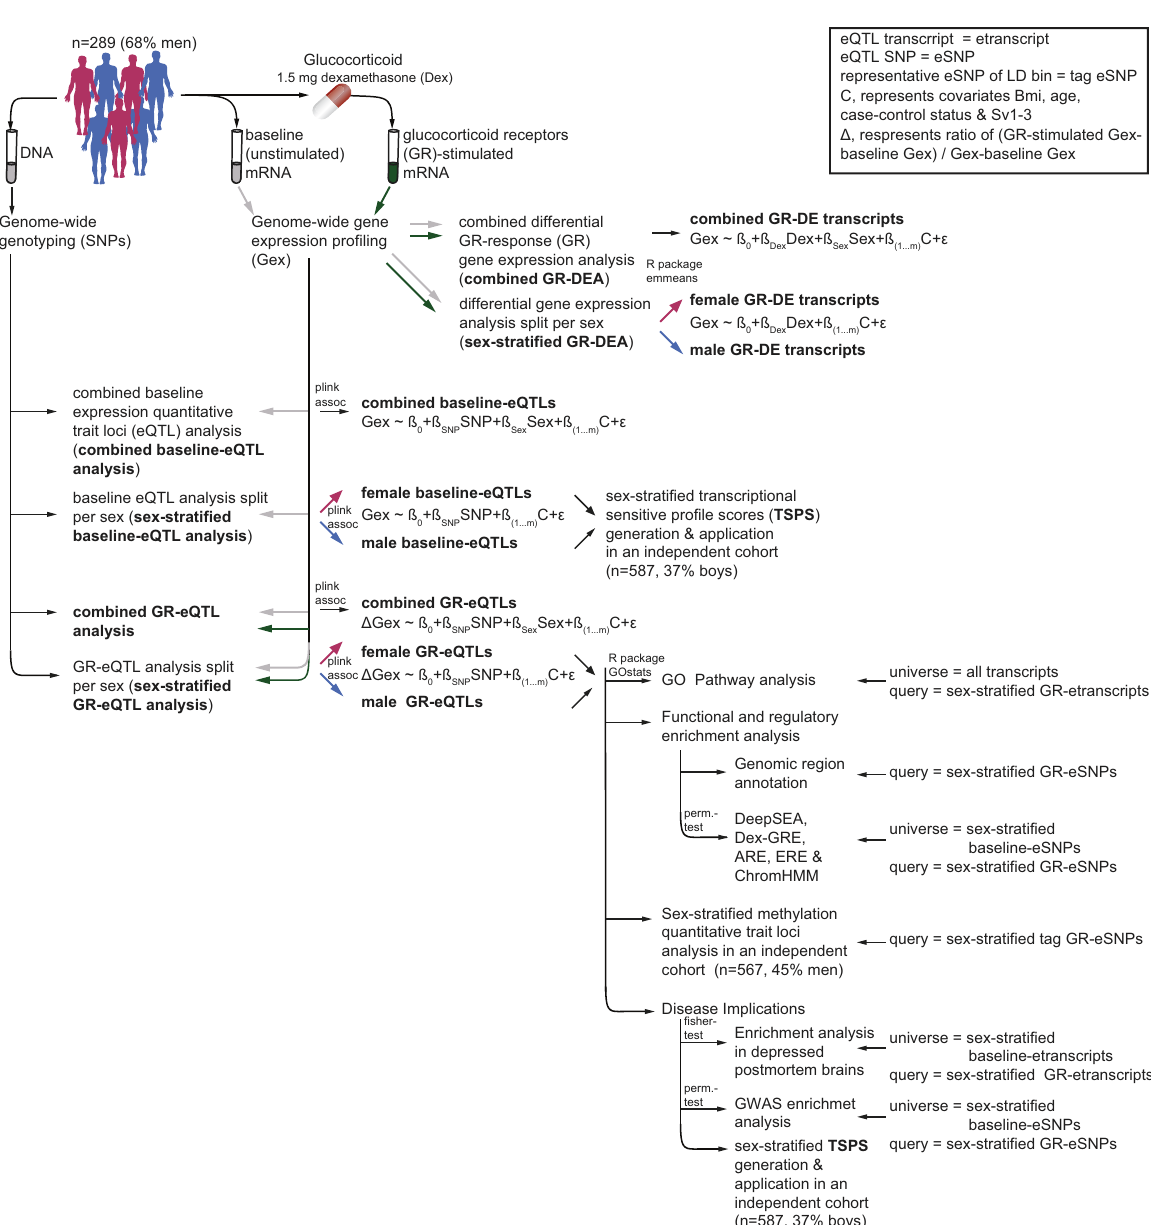
Fig. 1 Study Design and Work Flow. Flow of data collection and statistical analyses: Genome-wide genotyping and gene expression pro fi ling were used to examine differential GR-response gene expression and expression quantitative trait loci in (1) combined and (2) sex-strati fi ed analyses. Results were carried forward for functional interrogation and linkage to